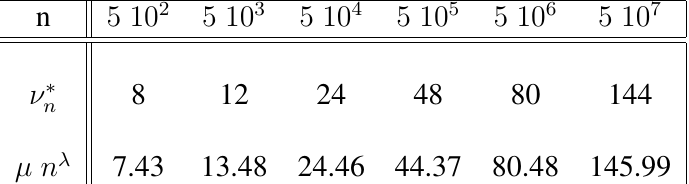
= µn λ for some values n